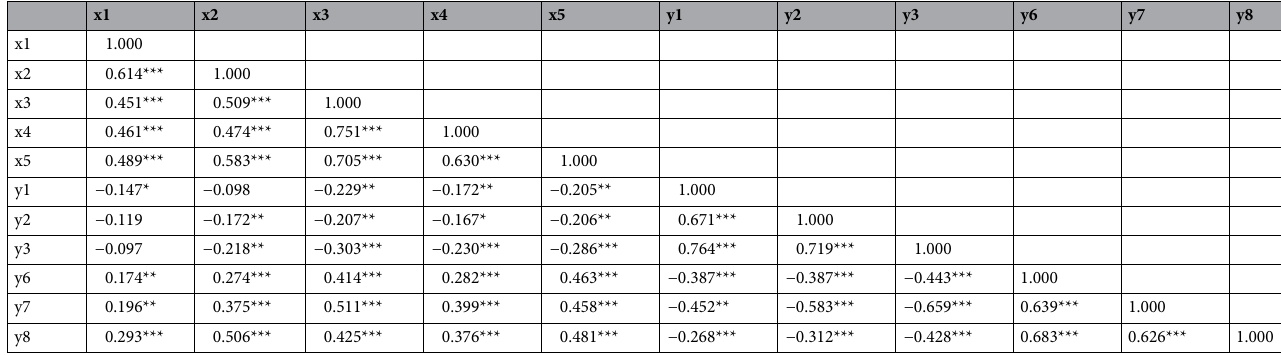
Table 3. Correlation among the observed variables. x1 = social support (parent), x2 = social support (teacher + close friend), x3 = sense of coherence (meaningfulness), x4 = sense of